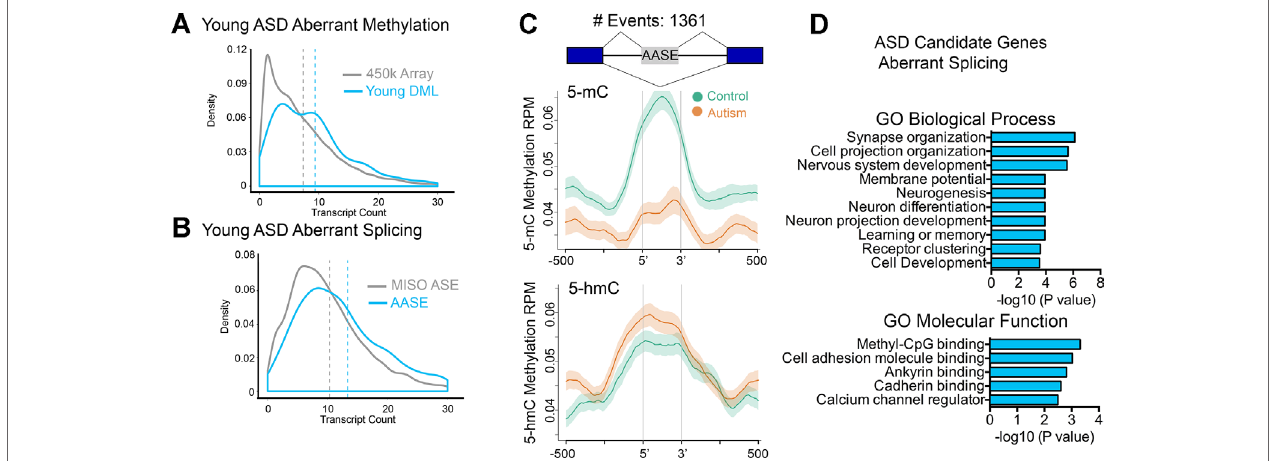
FIgURE 3 | Altered intragenic DNA methylation in ASD associates with aberrant pre-mRNA splicing. (A) Density plot of transcript count for gene-associated related CpGs in the 450k array (gray line) and for DML in the young age group (blue line). Dashed lines indicate mean. (B) Density plot of transcript count for genes containing alternatively spliced exons annotated in MISO database (gray line) and for aberrantly alternatively spliced exons related to autism in the young age group (blue line). Dashed lines indicate mean. (C) Distribution of 5mC and 5hmC methylation over the indicated bp window of all aberrantly alternatively spliced exons (AASEs) associated with autism. Methylation of control (green line) and autism (orange line) are displayed as mean RPM values with SEM indicated as a semitransparent shade around the mean curve. Total number of AASEs is displayed. (D) Functional annotation of ASD candidate genes that were aberrantly spliced in the young ASD group by GREAT analysis. Enrichment in Gene Ontology biological process and molecular function categories are shown for young autism group.